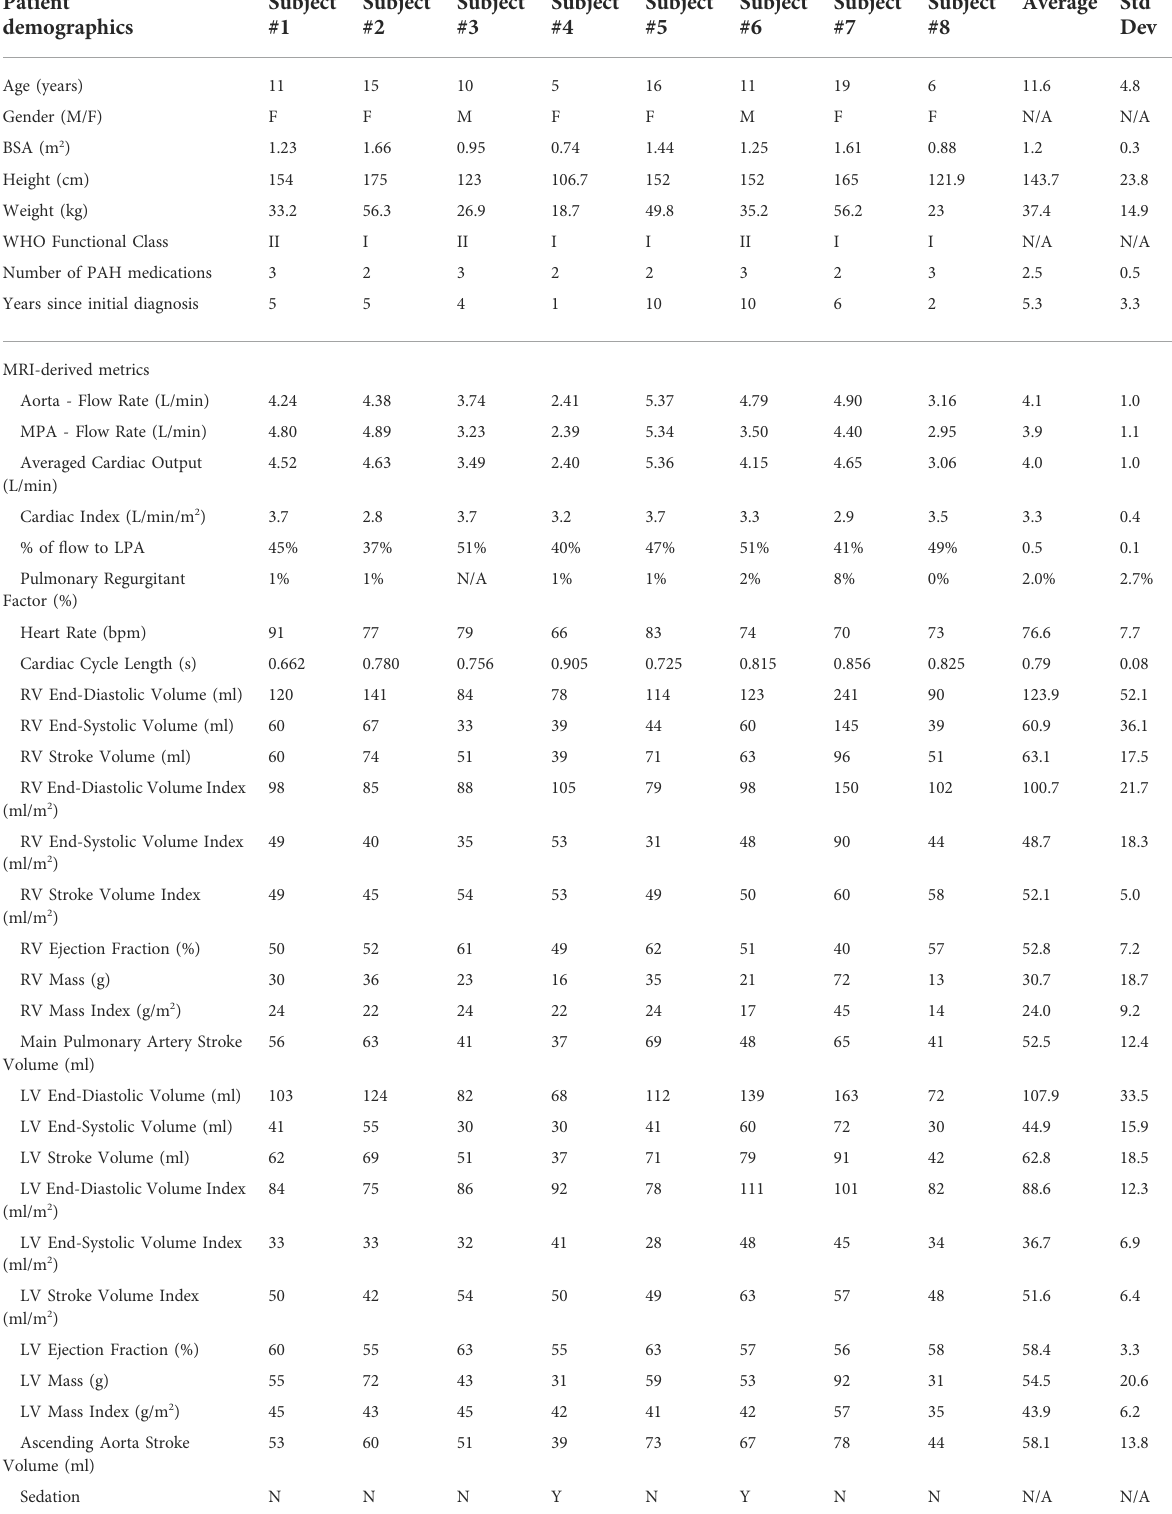
TABLE 1 Summary of patient demographics and clinical metrics (MRI- and